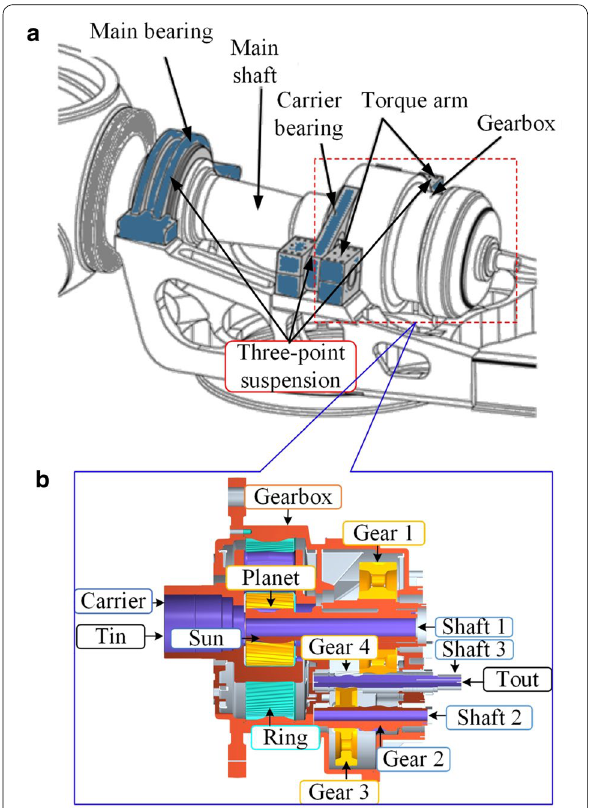
Figure 1 Structure diagram of a wind turbine drivetrain: a a whole structure view of drivetrain, b a transmission structure view of gearbox